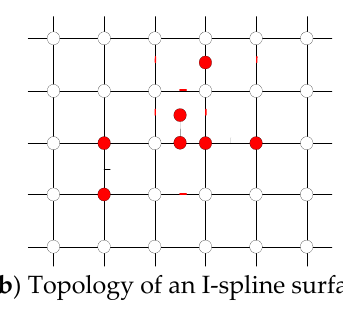
Figure 4. I-spline topologies.